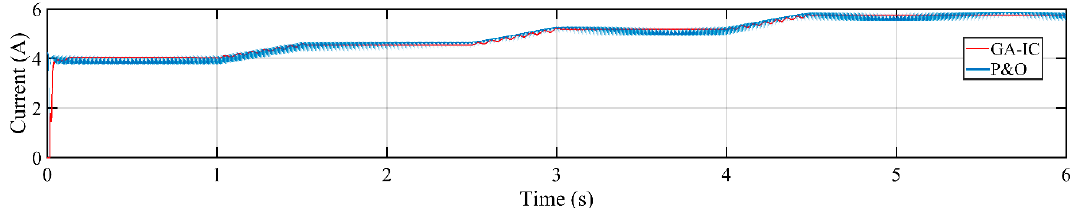
Figure 29. Case 2 current, detailed comparison of modified GA-IC vs. P&O.